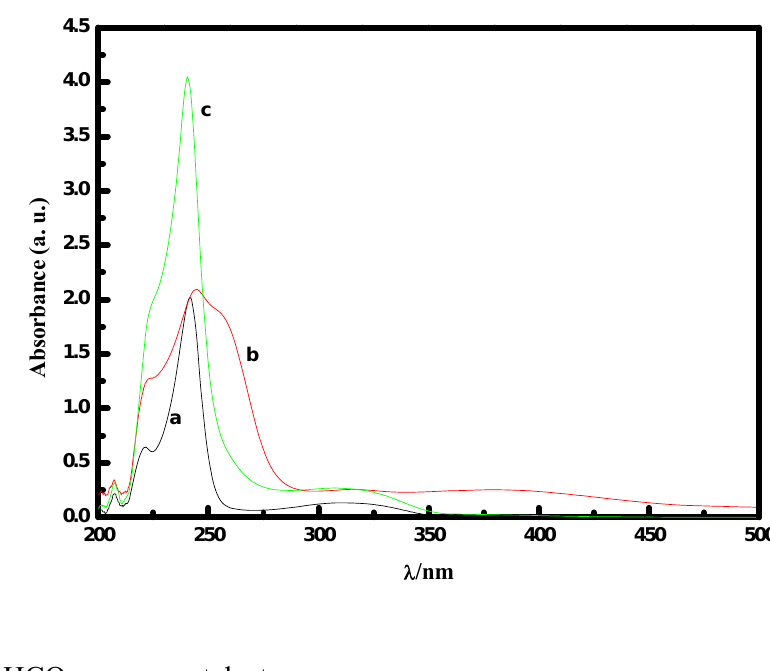
Figure 1. The UV-Vis spectra of 8-quinilinol (curve a), [MoO(O 2 ) 2 ·2QOH] (QOH = 8- quinilinol) (curve b), [MoO(O (curve